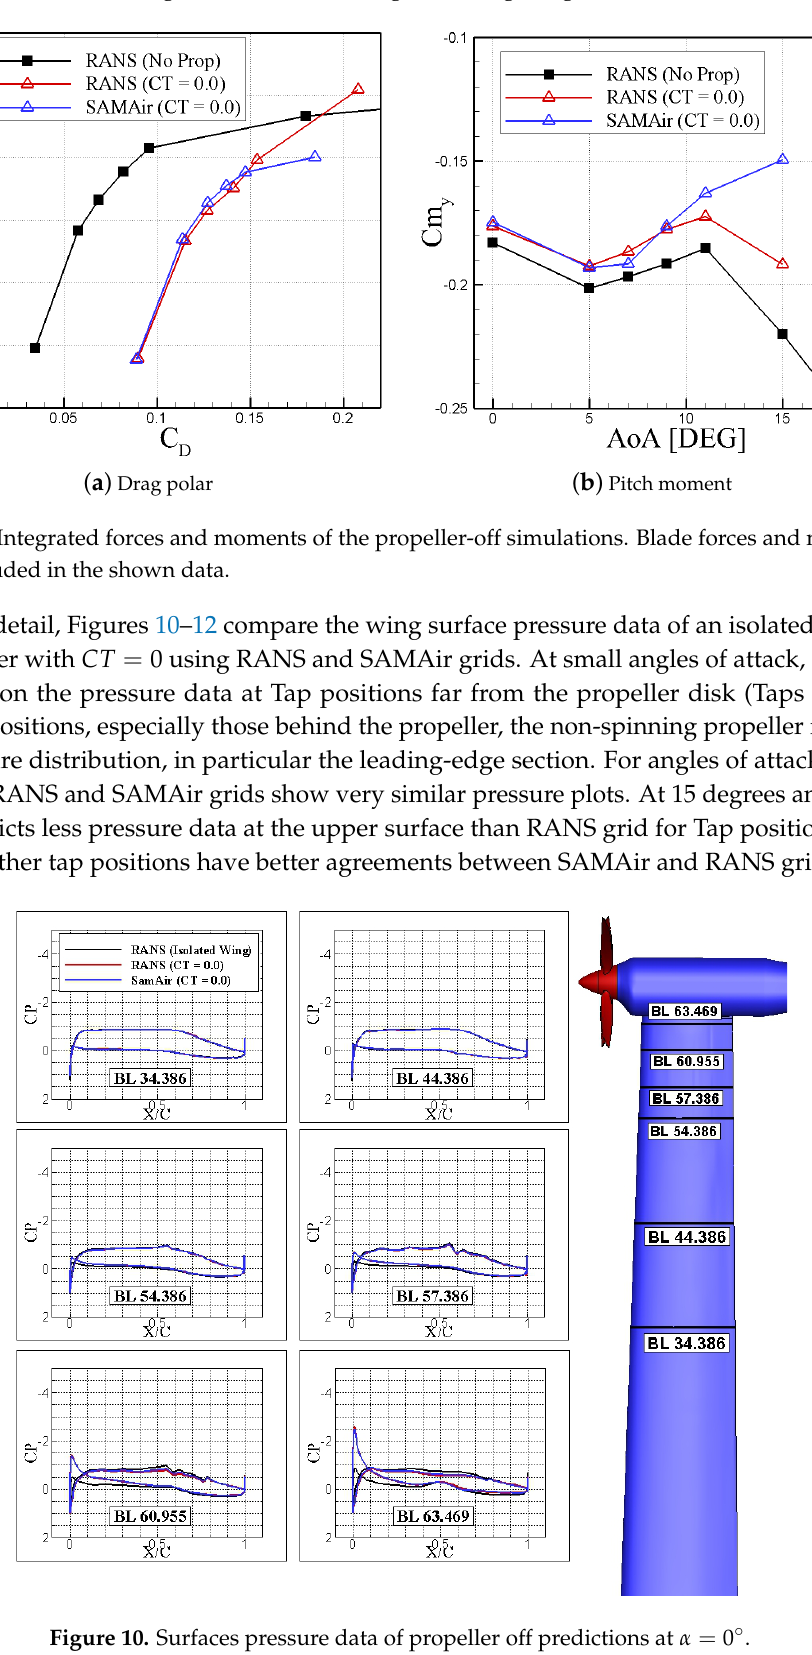
Figure 10. Surfaces pressure data of propeller off predictions at α = 0 ◦